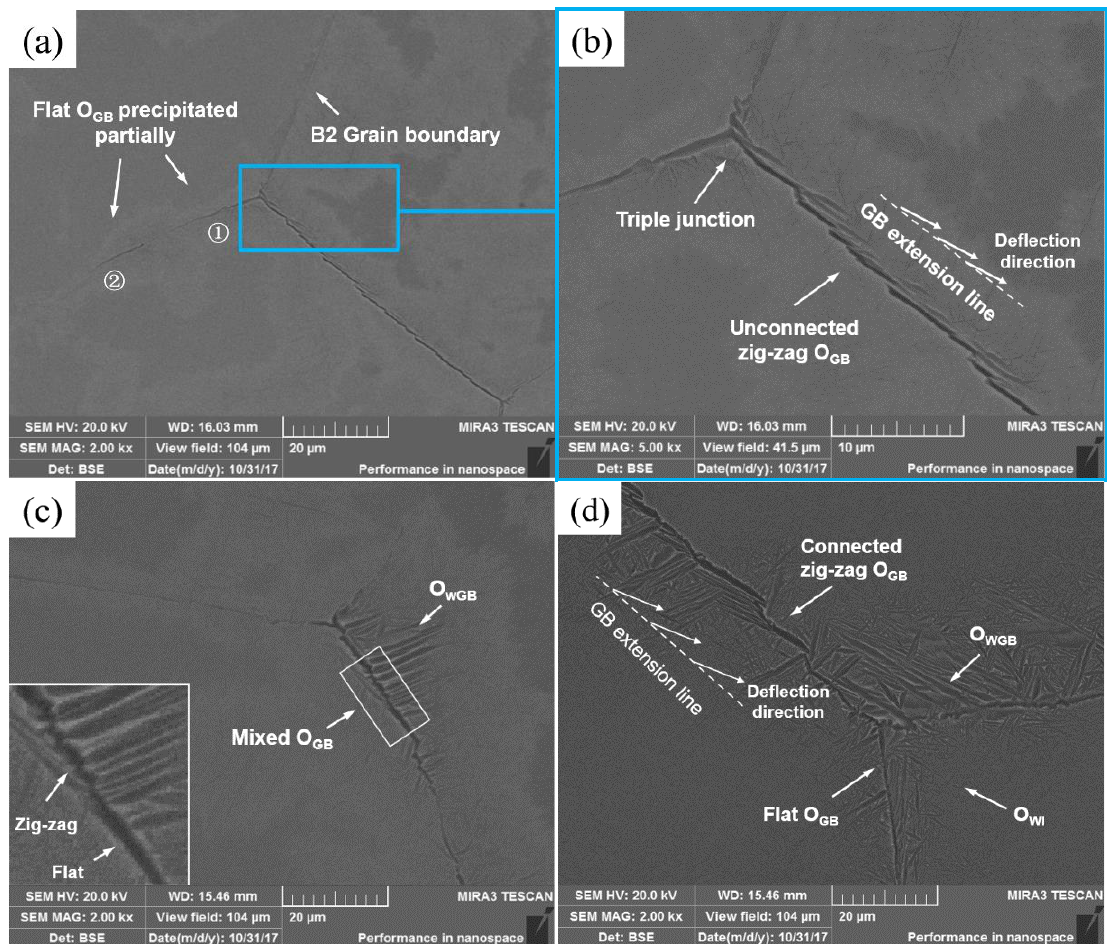
Figure 3. The morphology of Ti-22Al-25Nb alloy cooled at different rates from 1100 °C: ( a ) and ( b ) 1 °C/s, ( c ) 0.4 °C/s, ( d ) 0.1 °C/s.